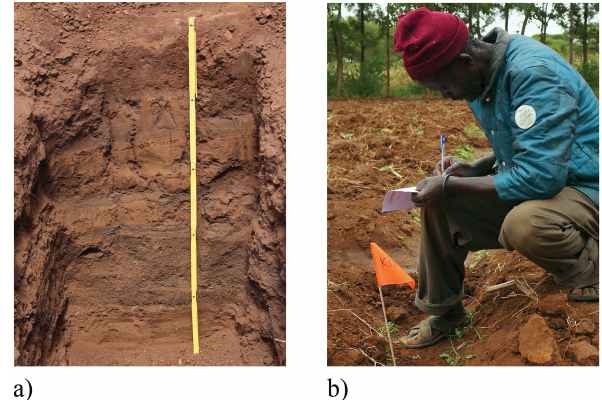
Figure 2. (a) Typical soil profile in the area where the wetness clas- sification scheme was tested (profile depth: 1m). (b) Farmer assess- ing the soil wetness conditions using the qualitative soil wetness scheme. (Photo: (a) D. Müller, (b) M.